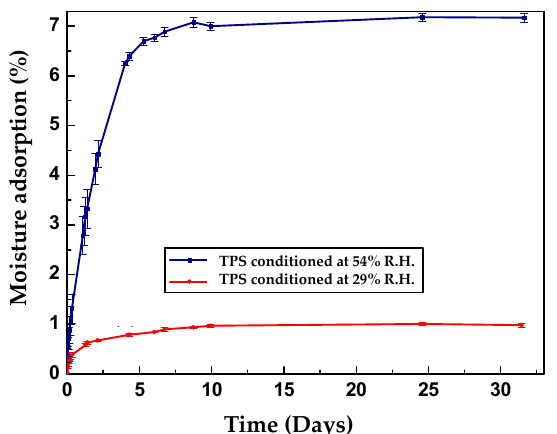
Figure 4. Adsorption isotherms at different storage times for TPS samples conditioned at 29% and 54% relative humidity.